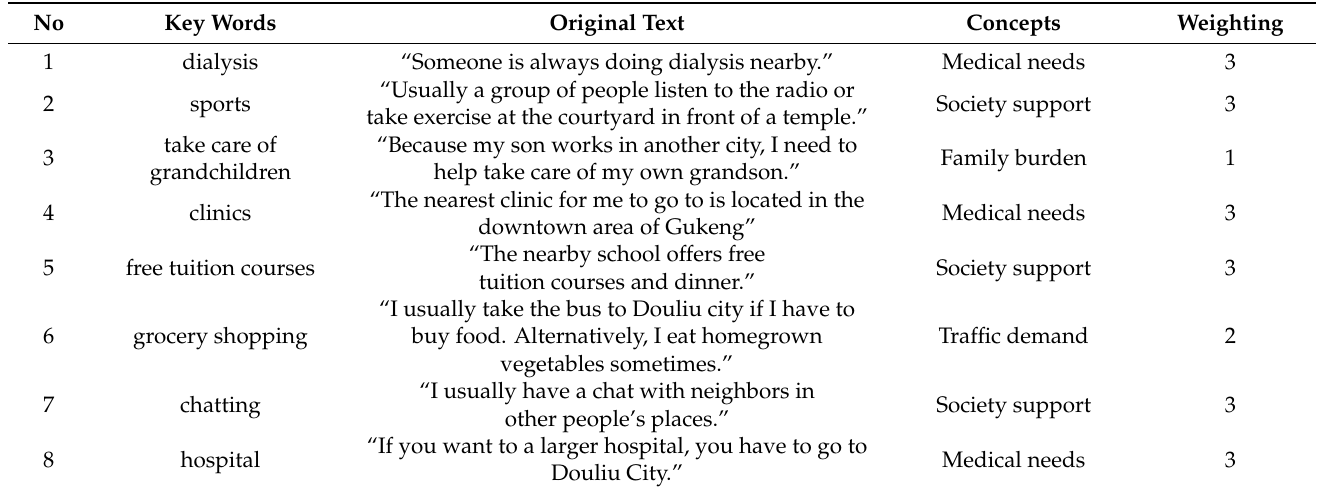
Table 2. Examples of meaningful codes for the main concepts in qualitative